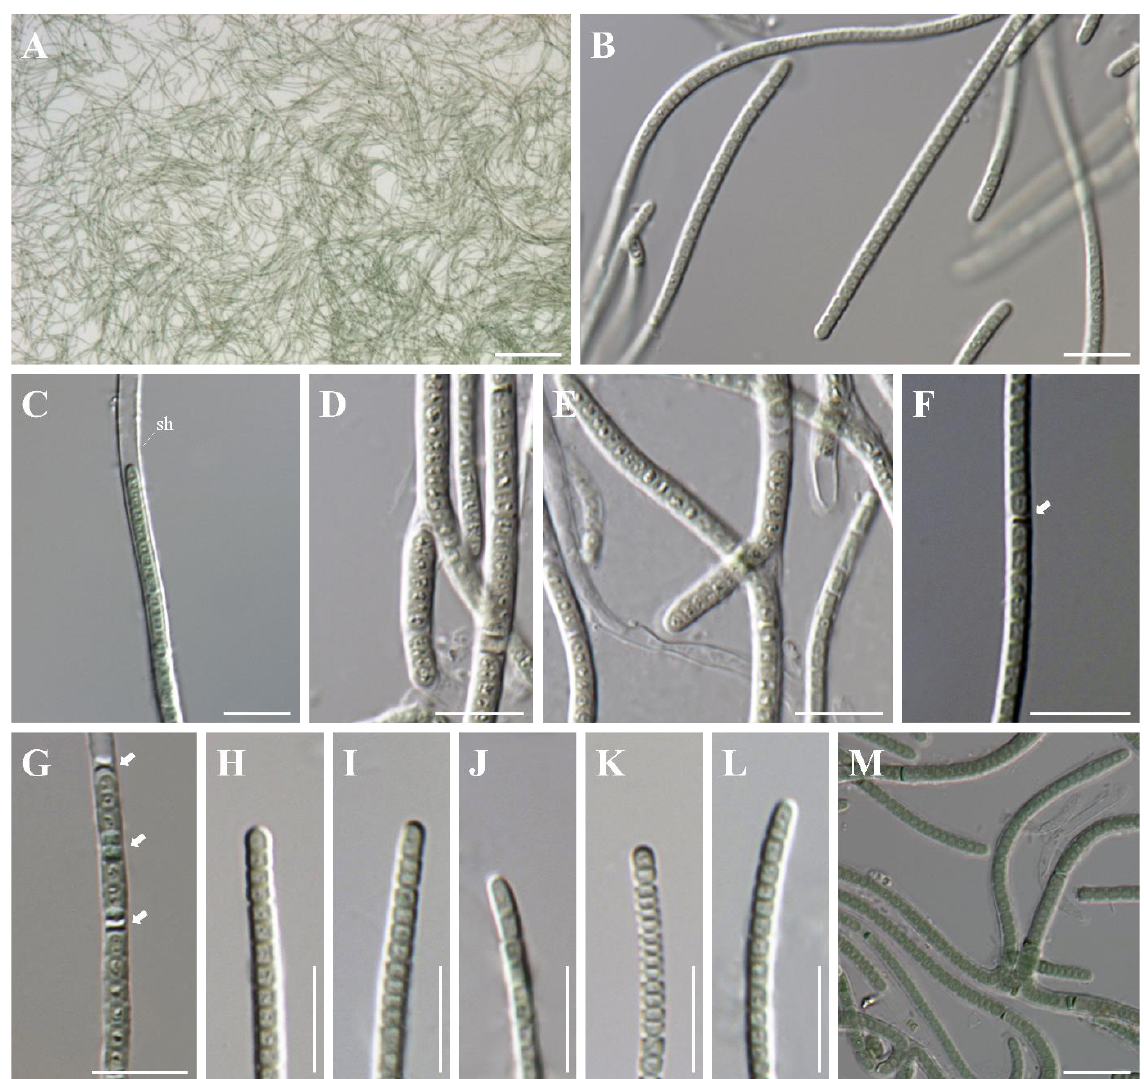
Figure 2. Microphotographs of Plectolyngbya terrestris from the strain FBCC-A1479. ( A ) Colonies (mats) formed in the culture. ( B , C ) Detail of trichomes; (sh) sheaths, ( D ) Tolypothrix -type of false branching, ( E ) Scytonema -type of false branching, ( F , G ) Arrows indicate the necridic cells, ( H – L ) Morphologies of apical cells. ( M ) Trichome with sheaths after 4 weeks of culture. Scale bars ( A ) 100 μm, ( B – M ) 10 μm.